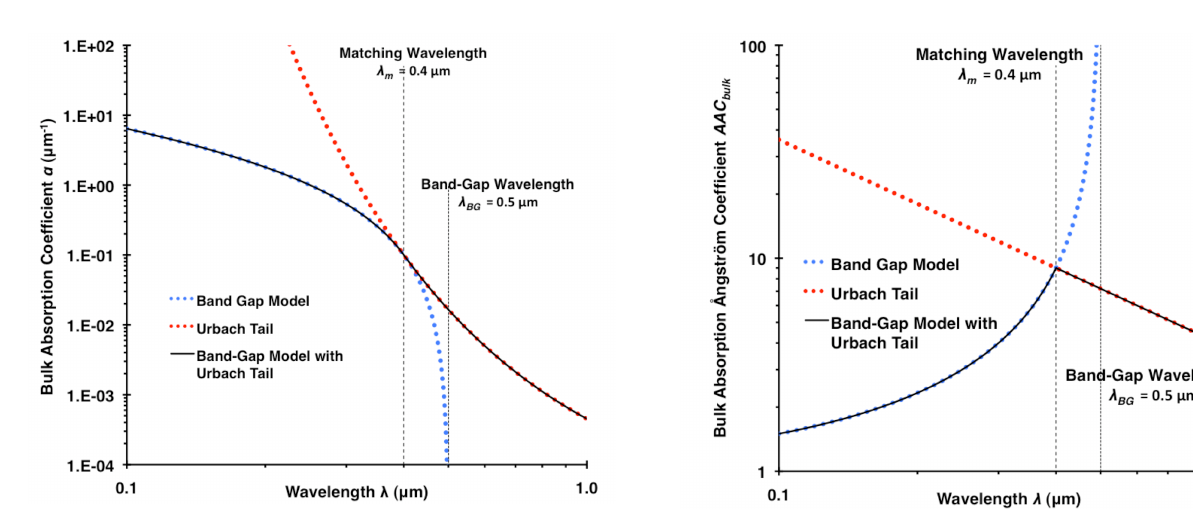
Fig. 5. Bulk absorption ˚ Angstr¨om coefficient AAC bulk calculated with the band-gap model (blue dotted line), the Urbach-tail exten- sion (red dotted line), and the band-gap model with Urbach tail (black solid line). Parameters used for this example are λ BG = 0 . 5µm, λ m = 0 . 4µm, and λ 0 = 3 .